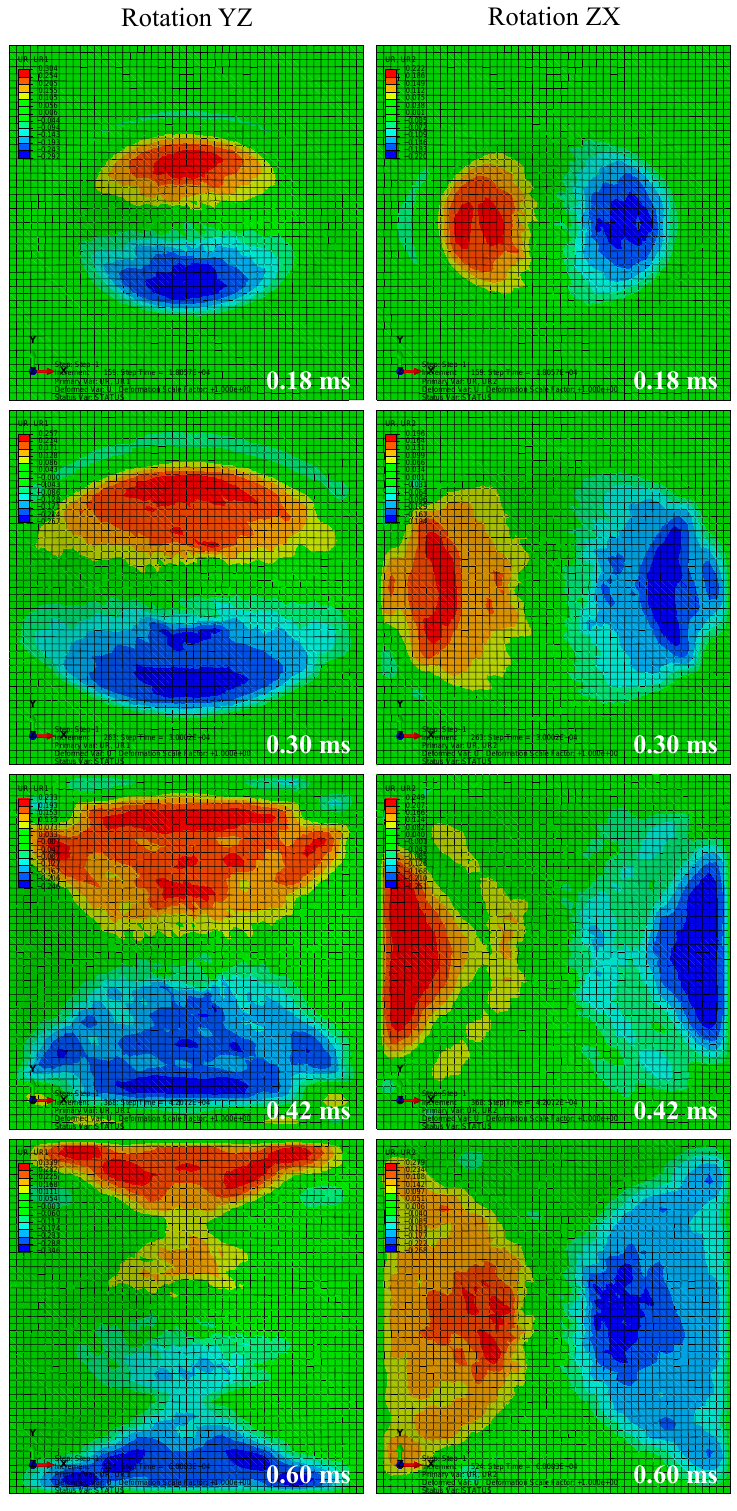
Figure 5. Rotational deformations of the laminates with material